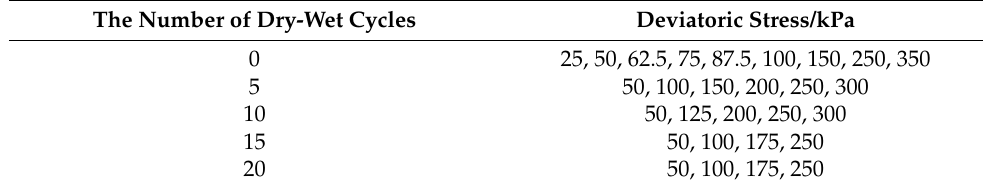
Table 2. Loading scheme of the triaxial creep test.